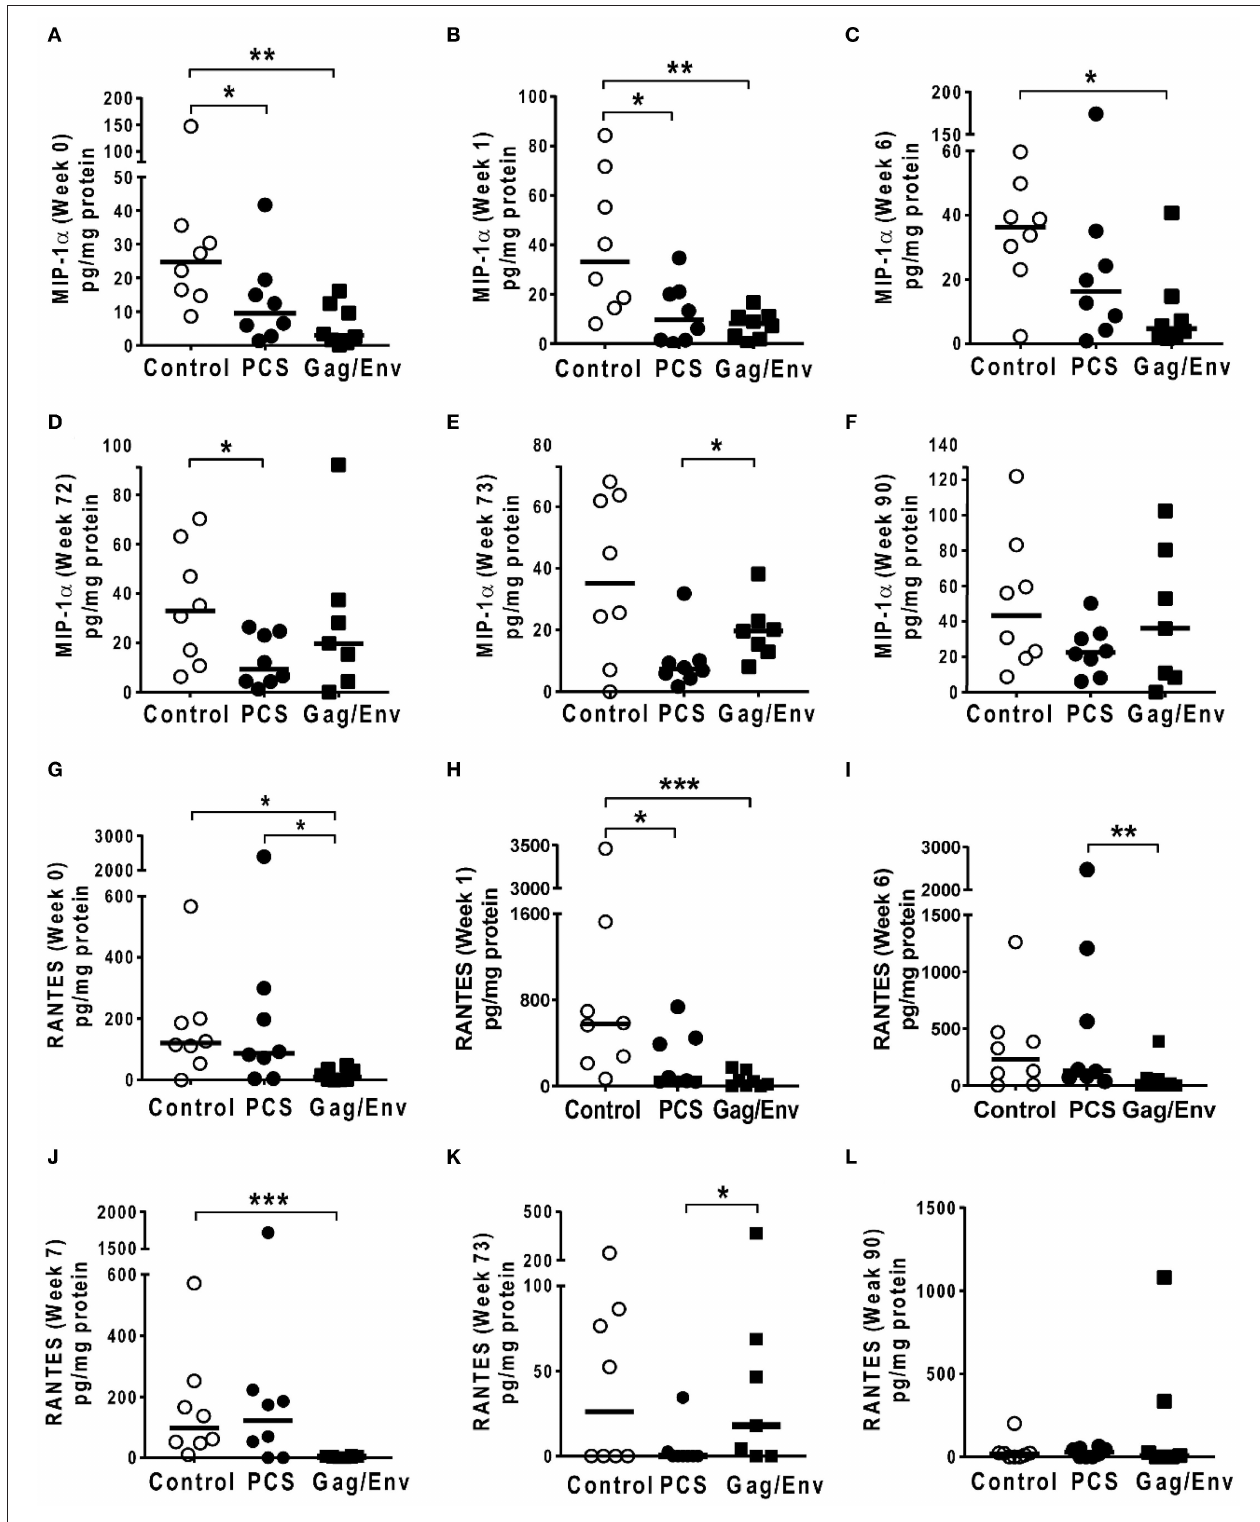
FIGURE 8 | Significant differences in CVL levels of MIP-1 α , and RANTES among the 3 vaccine groups at different time points including Week 0 and 90 analyzed using Mann-Whitney t -test. Data presented as values from individual monkeys with median. (A–F) MIP-1 α (G–L) RANTES. n = 8 monkeys/group ( n = 7 for Gag/Env). Experiments were run in duplicates. * P < 0.05, ** P < 0.01, and *** P < 0.001. Non-significant differences between groups were not included.